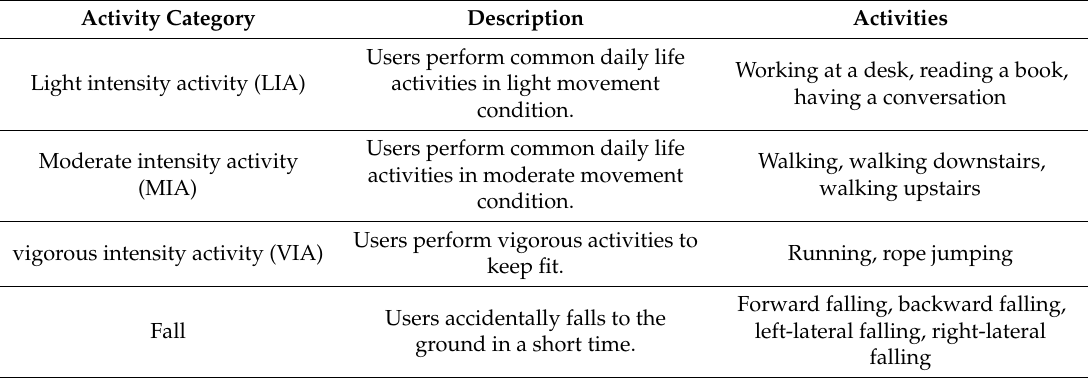
Table 1. Categorization of different activities.